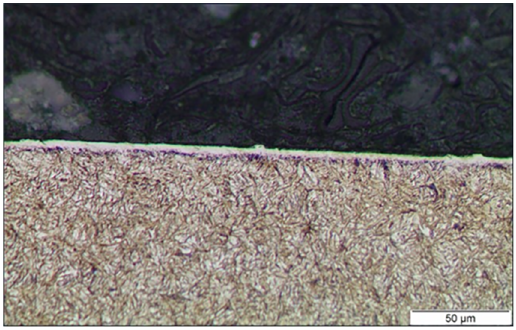
Figure 3. Metallography of machined surface of specimen 3 and respective white layer identified. Increase of 500x with attack of Nital 2 %